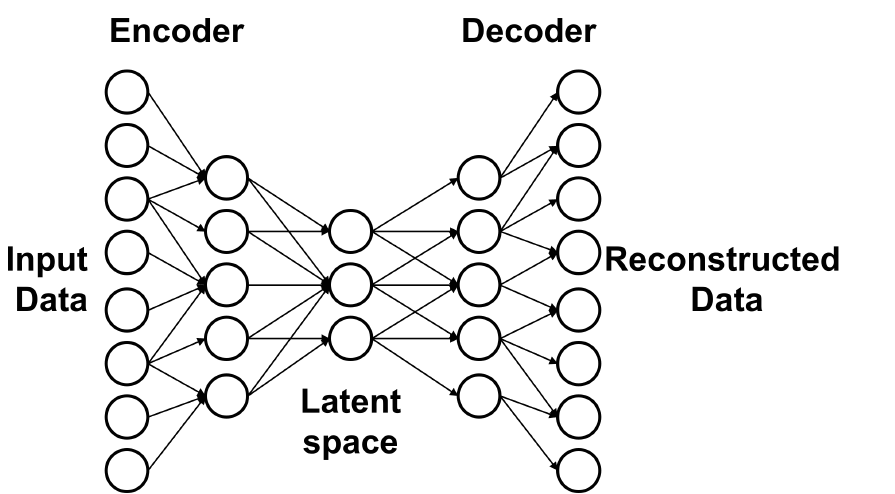
Figure 1. Schematic representation of an autoencoder. The input data are compressed by the encoder to a smaller number of features in the latent space. The decoder tries to reconstruct the original data from the compressed one.